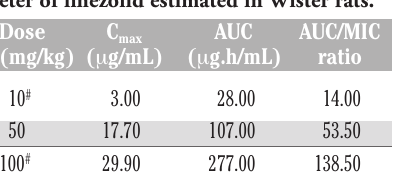
Table 3. Selected pharmacokinetics param- eter of linezolid estimated in Wister